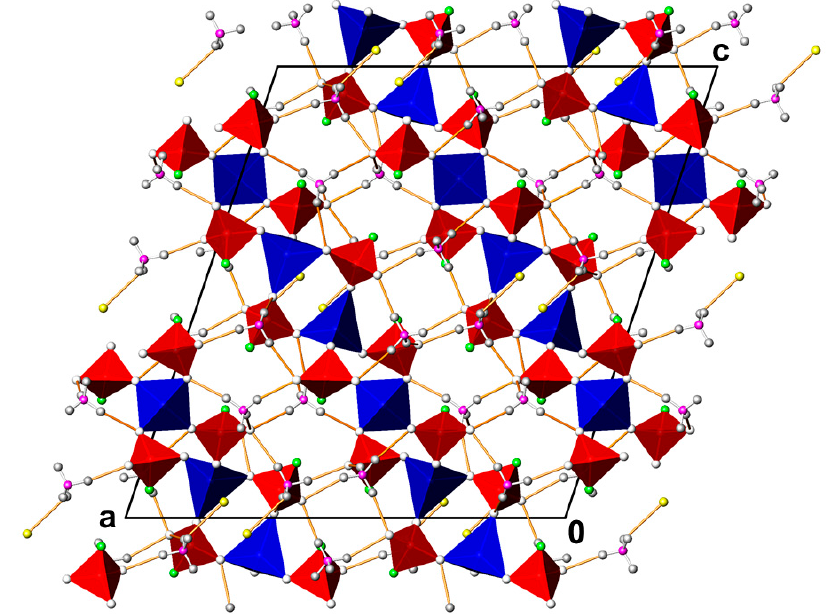
Figure 11. The crystal structure of (NH 4 ) 2 Zn(PO 3 F) 2 (H 2 O) 0.2 in a projection along [010]. Colour code of PO 3 F tetrahedra and H atoms as in Figure 1; O atoms of disordered crystal water molecules are given as yellow spheres. For clarity, disorder involving parts of the [ZnO 4 ] and PO 3 F tetrahedra is not shown.